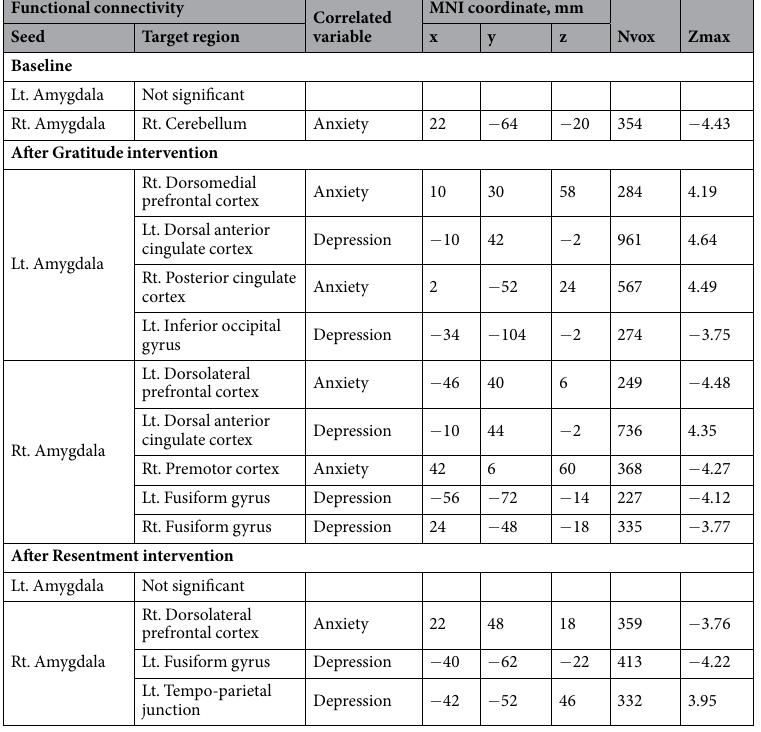
Table 2. Relationships between amygdala-based functional connectivity and subscales of the hospital anxiety and depression scale. Significant clusters were obtained at family-wise error rate corrected P < 0.05. Abbreviation: Lt, left; MNI, Montreal Neurological Institute; Nvox, number of contiguous voxels; Rt, right; Zmax, maximum z-value within the